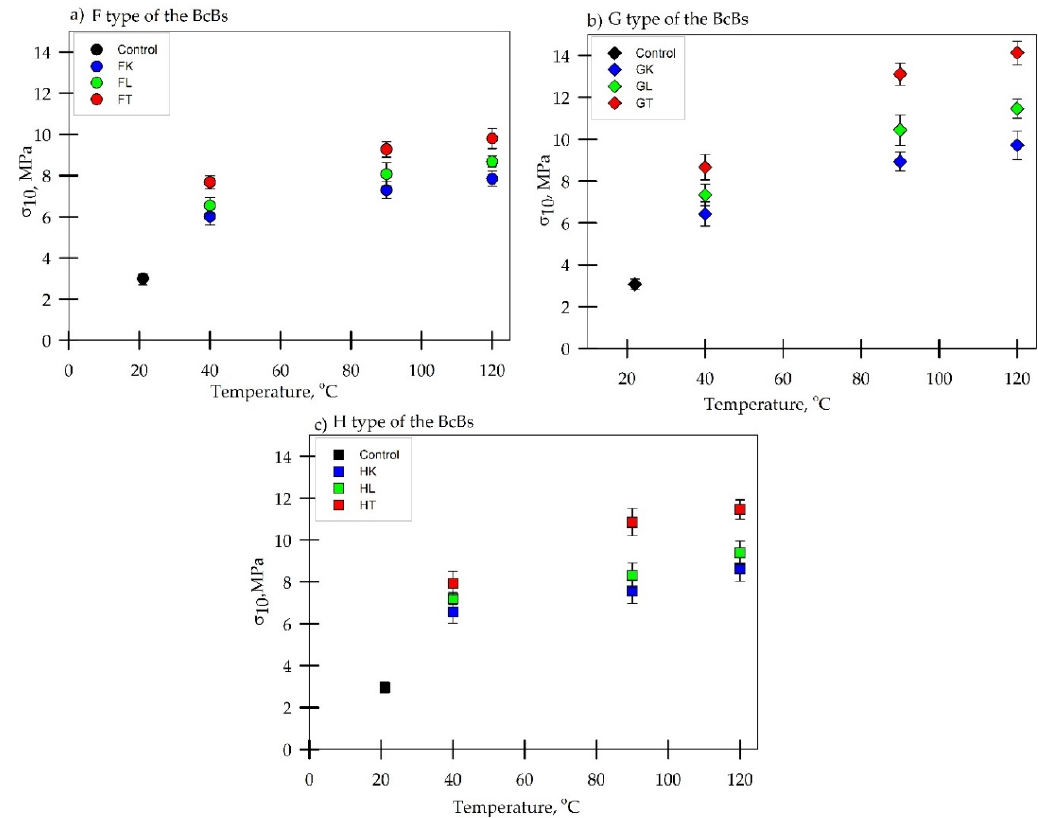
Figure 6. Compressive stress at 10% deformation of BcBs with different oil-impregnation at different temperatures:( a ) F type of the BcB with hempseed oil (K), linseed oil (L), and tung tree oil (T); ( b ) G type of the BcB with hempseed oil (K), linseed oil (L), and tung tree oil (T); ( c ) H type of the BcB with hempseed oil (K), linseed (L), and tung tree oil (T).